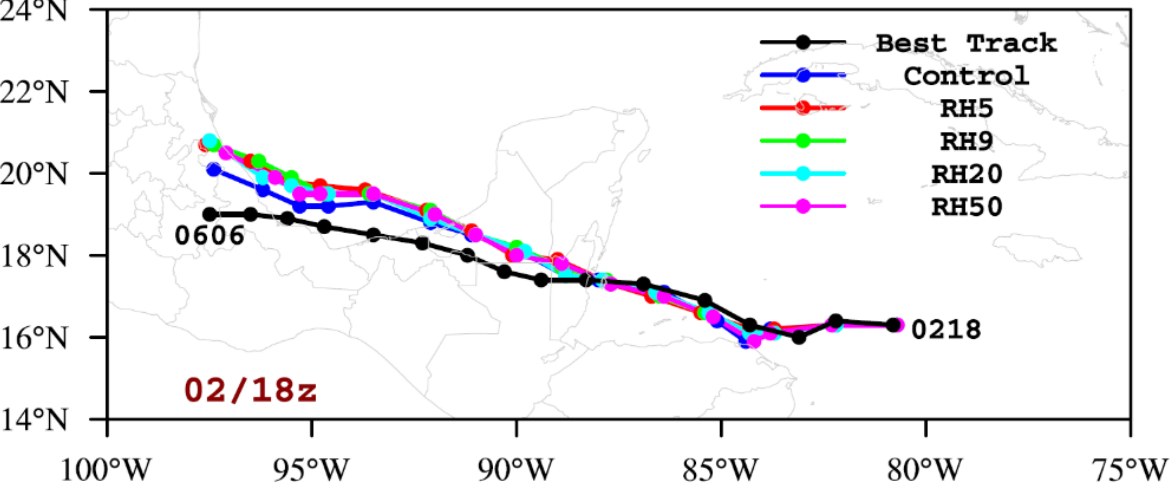
Figure 7. Comparison of the forecast track for Hurricane Earl from different TDR data thinning experiments against Control and best track at 18 UTC 2 August 2016. Table 4. The 36 h forecast errors from data thinning experiments with radar radial wind assimilation at 18 UTC 2 August 2016.